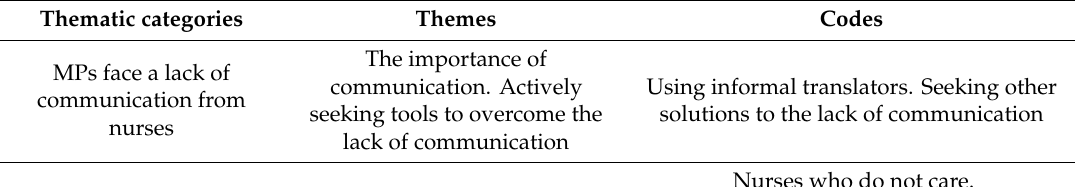
Table 2. Thematic categories, themes and